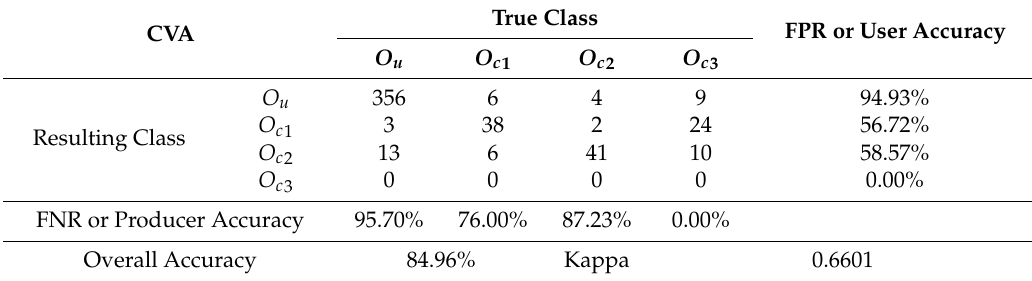
Table 4. The accuracy assessment for the OBCD result obtained by the standard CVA